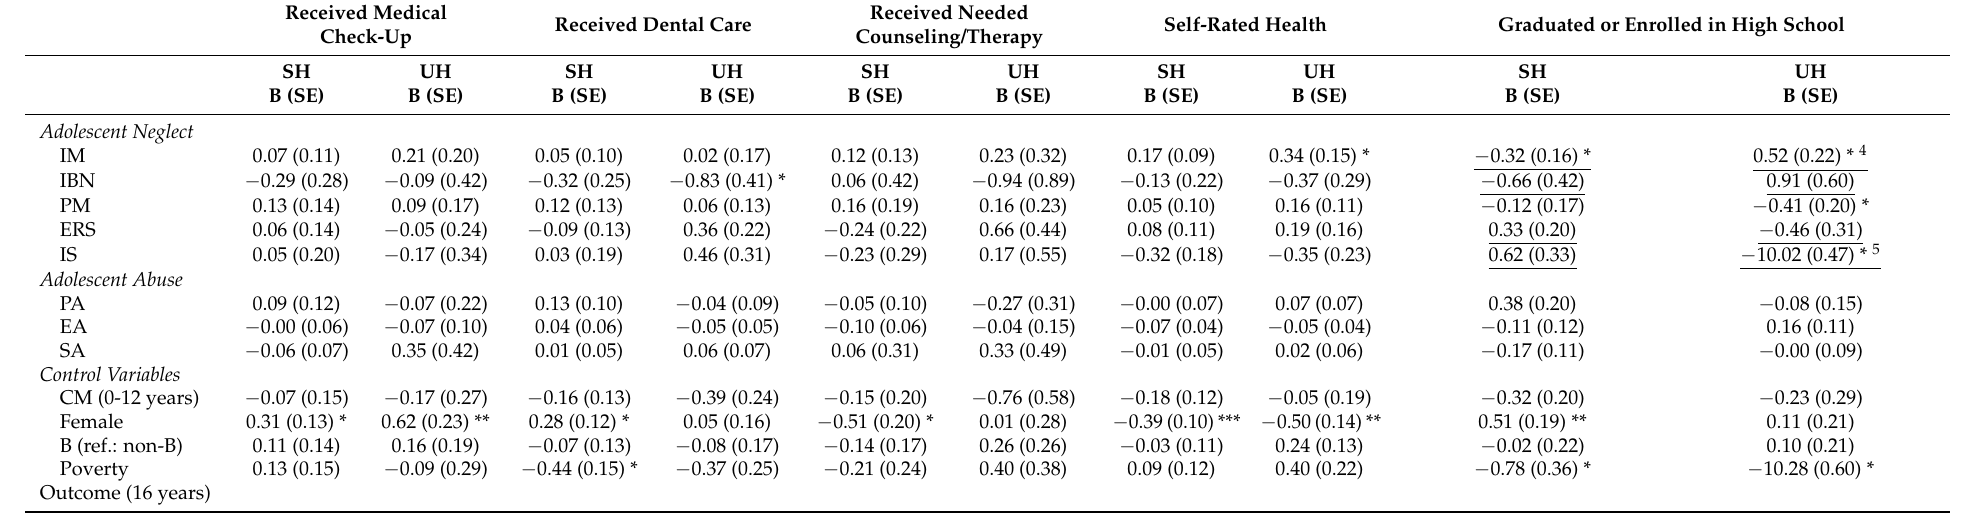
Table 5. Multigroup Structural Equation Models Predicting Functional Adaptations as Moderated by Housing Stability ( N =